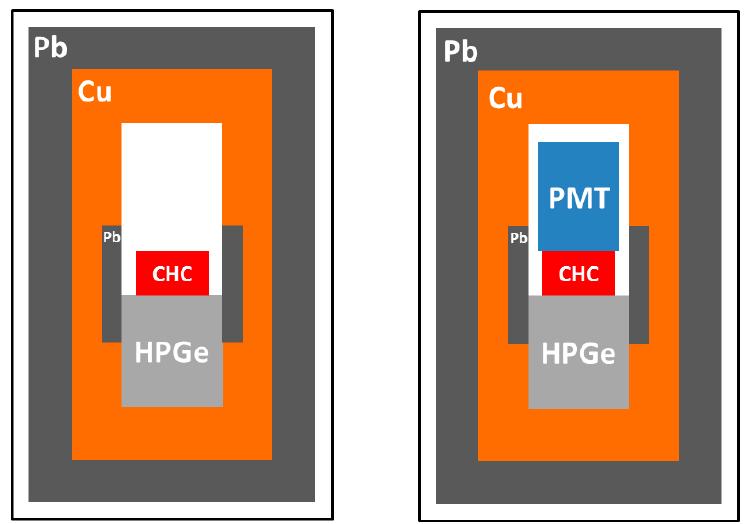
Figure 4. Left: Schematic cross-section view of the low-background experimental set-up with HPGe detector (not in scale) used for measurements of the radioactive contamination of raw materials, materials after purification and the final CHC crystals. Right: Adaptation of the same experimental set-up with HPGe detector for 174 Hf rare alpha decay measurements in a coincidence with scintillation channel (PMT). See more description in the text (Sections 9 and 10).